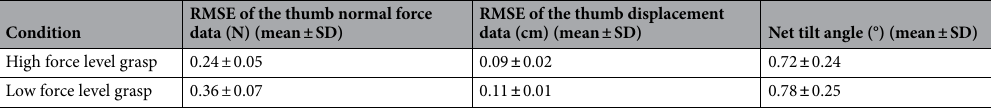
Table 1. Root mean square error of the thumb data and net tilt angle during high force level and low force level grasp conditions. The table shows the average net tilt angle of the handle and root mean square error on the thumb normal force and displacement data during both grasp conditions. The mean and standard deviation (SD) of the data are presented.